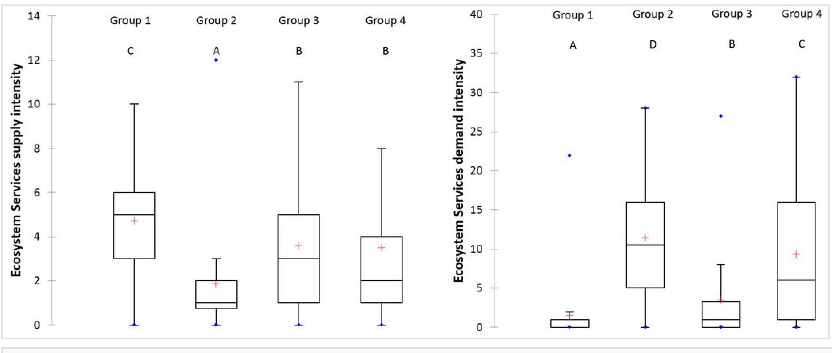
Boxplots of the intensity of ES supply (left) and demand (right) in the four groups of municipalities in the study area. Capital letters below the name indicate if there is any statistically signi fi cant di ff erence between the areas (di ff erent letter) or not (same letter) with a signi fi cance level of